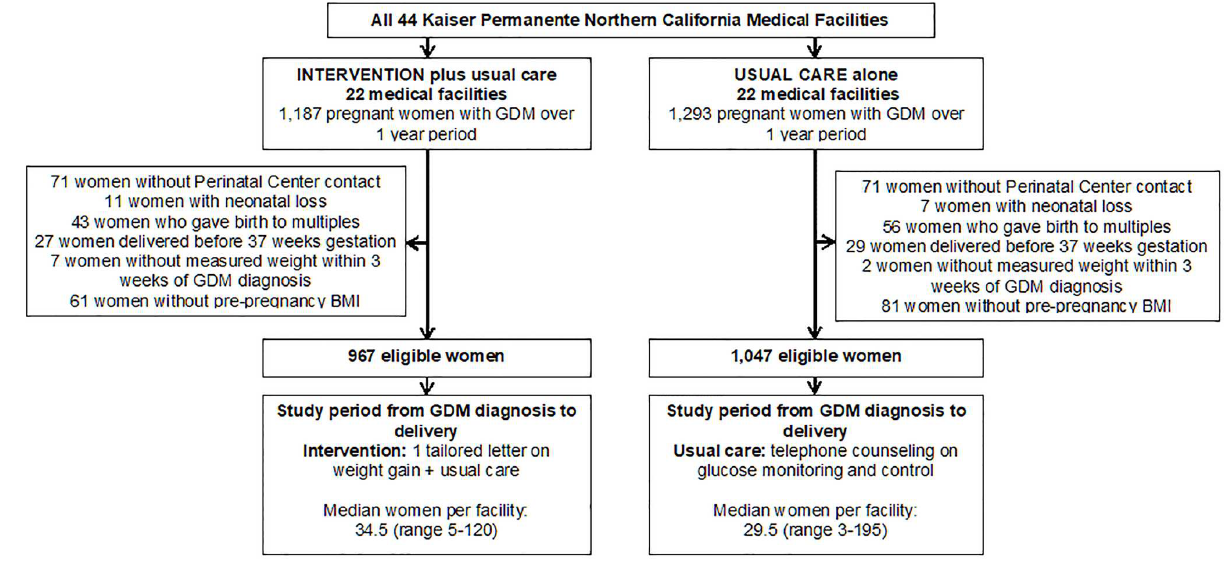
Fig 1. Overview of the pregnancy component of the GEM cluster randomized